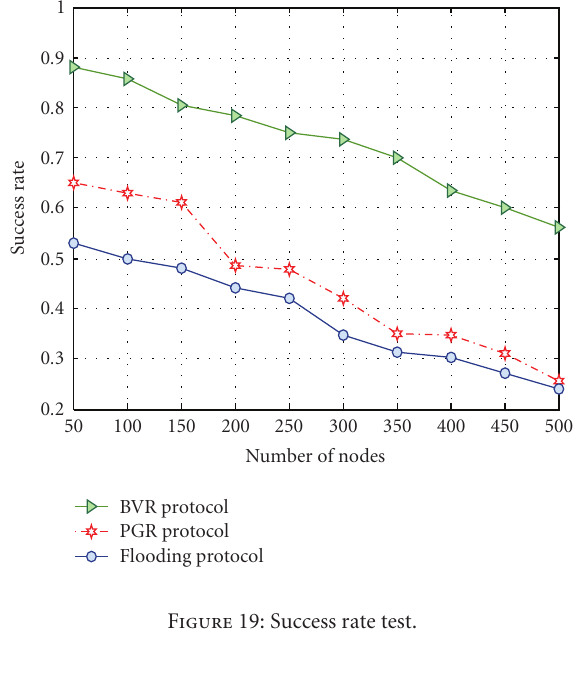
Figure 21: Latency test.